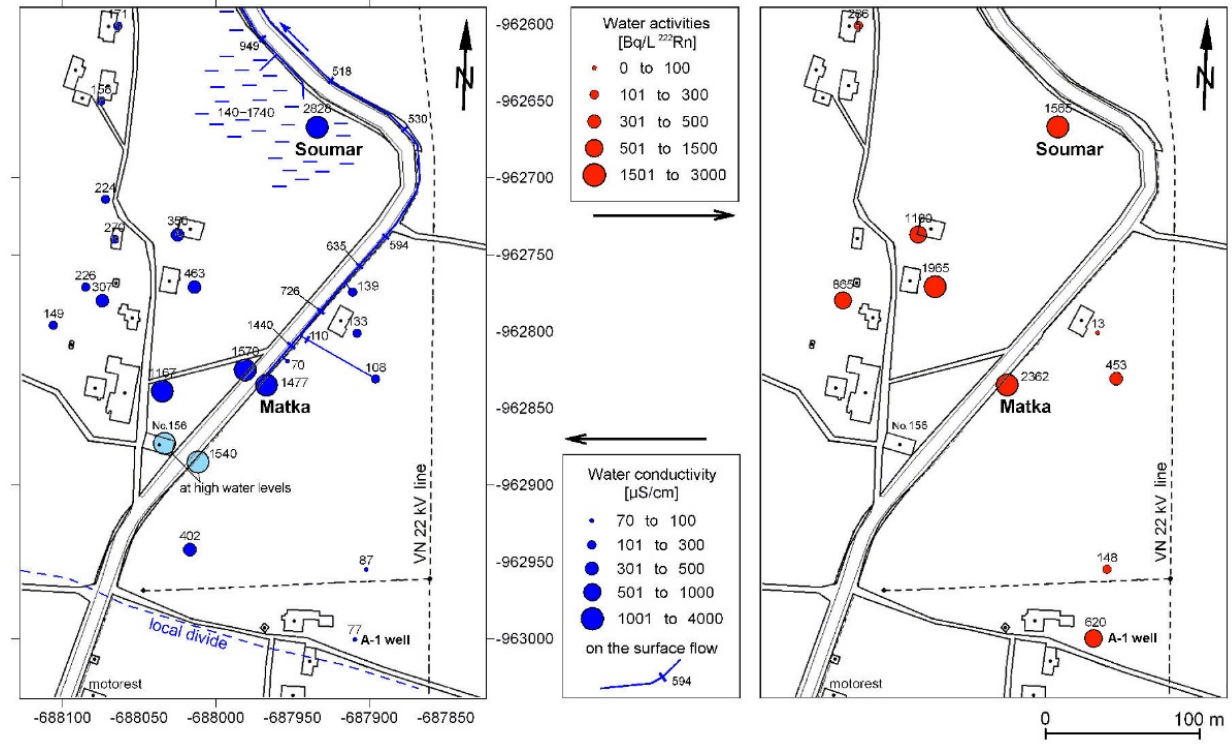
Figure 13. The Albrechtice chloride district. Modified from [70].